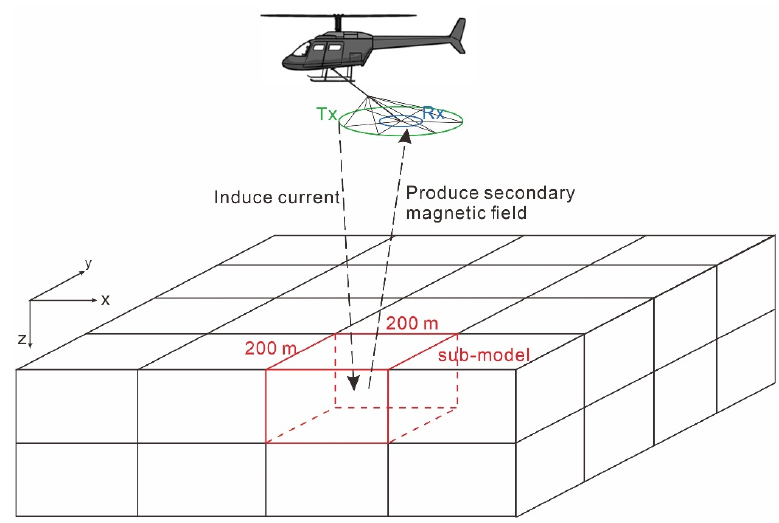
Figure A1. Sub-model based on the moving footprint.